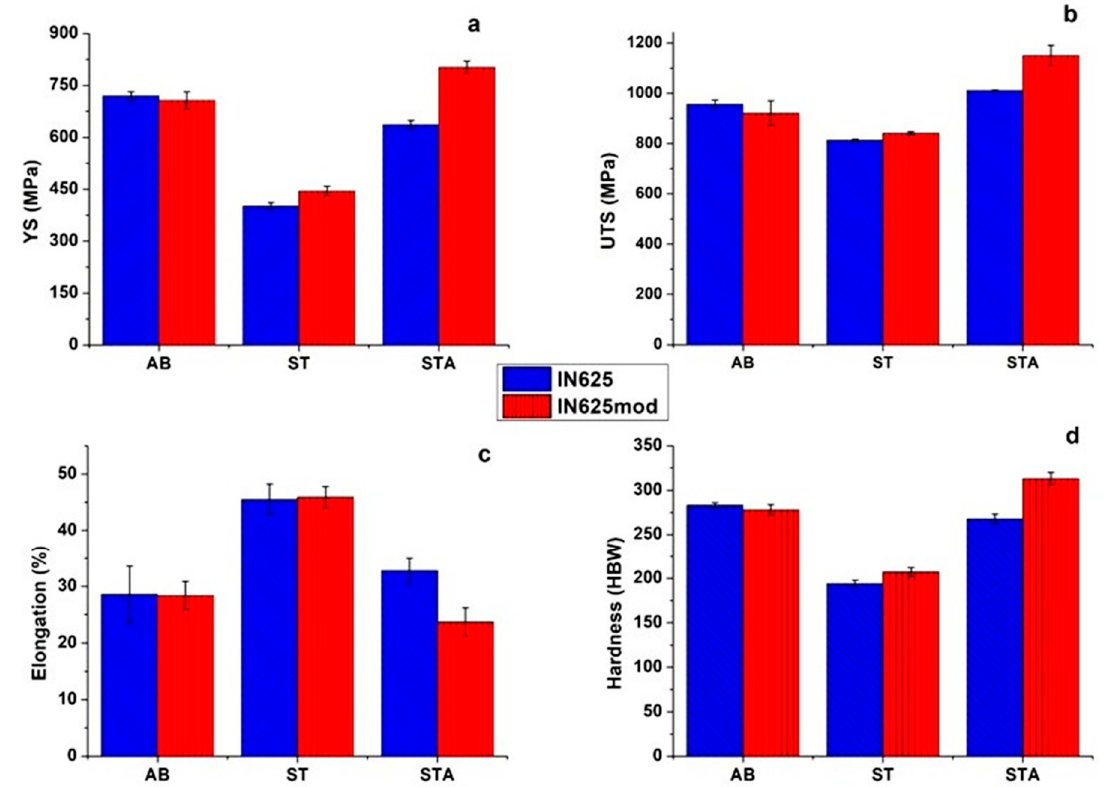
Figure 8. Mechanical properties of the IN625 and IN625mod in the different conditions: YS ( a ), UTS ( b ), elongation at failure ( c ), and Brinell hardness ( d ).